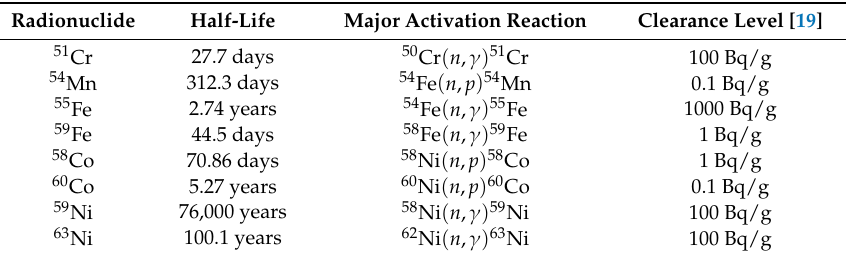
Table 5. Selected target radionuclides for activation calculation and major activation reactions [14–19].